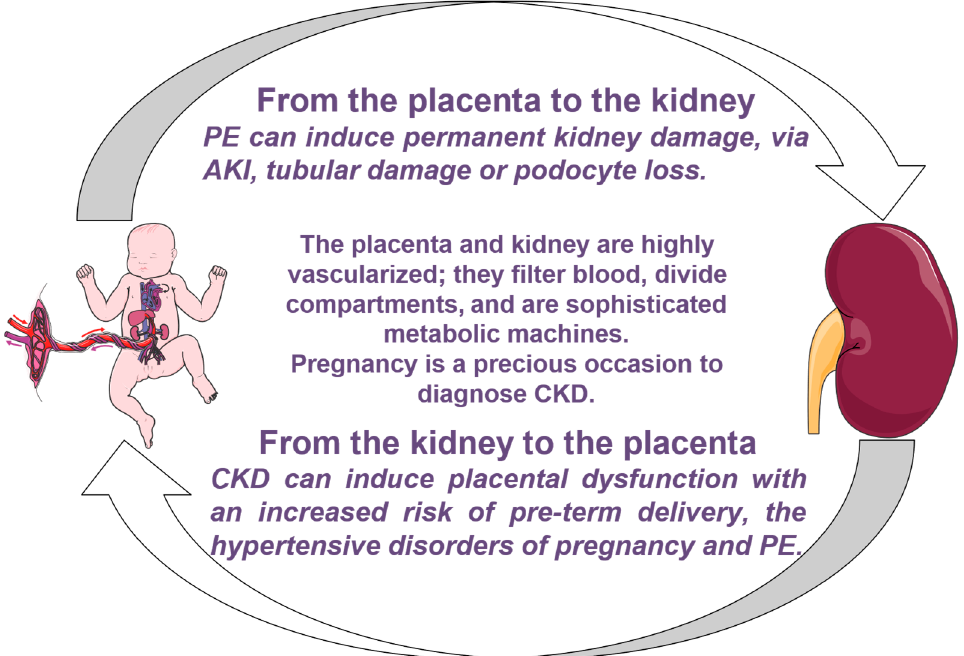
Figure 1. The vicious circle from the placenta to the kidney and from the kidney to the placenta. Adapted from [5]. PE: preeclampsia, AKI: acute kidney injury, CKD: chronic kidney disease.